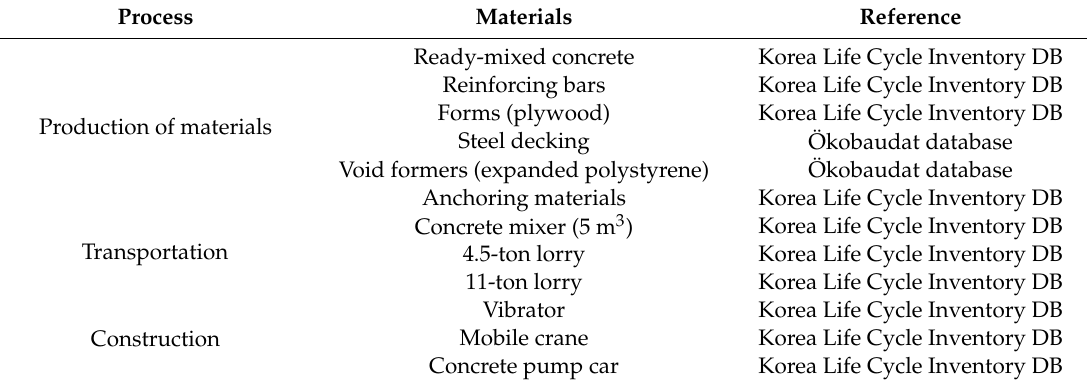
Table 2. Life cycle inventory